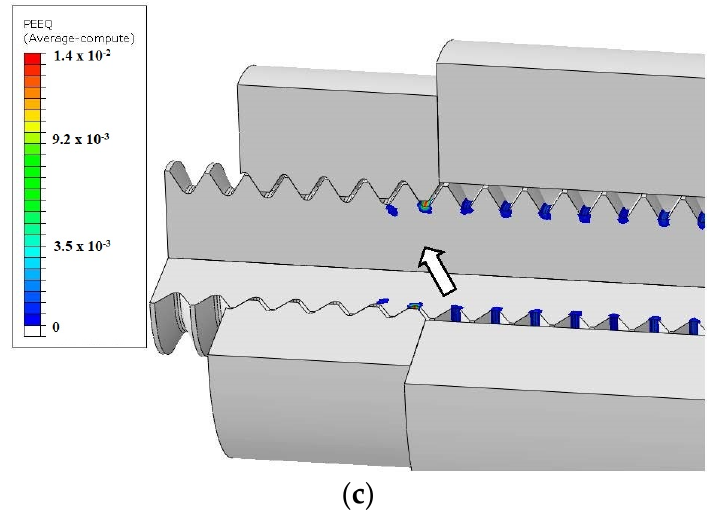
Figure 12. Strain (mm/mm) for Maximum Nominal stress of ( a ) 440.6 MPa (50% of the yield strength), ( b ) 616.8 MPa (70% of the yield strength), and ( c ) 793 MPa (90% of the yield strength).